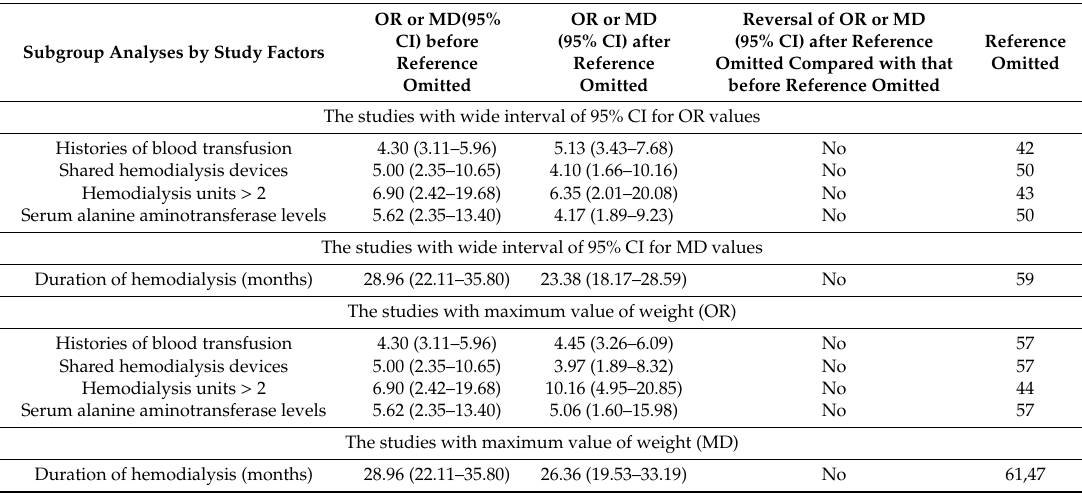
Table 2. The subgroup characteristics of study factors associated with HCV infection in hemodialysis patients after omitting the studies with maximum value of weight or widest interval of 95% CI for OR or MD values in subgroup